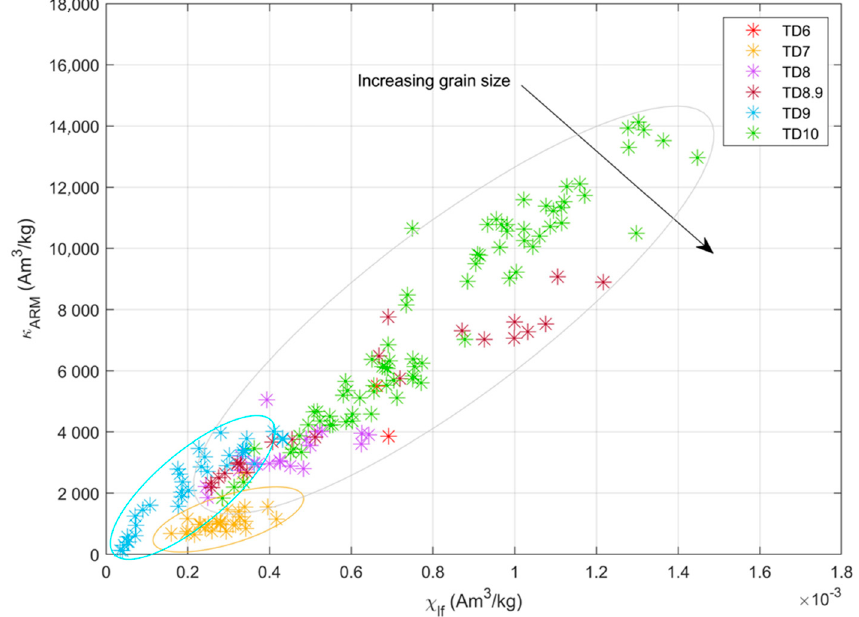
Figure 11. King plot of the di ff erent stratigraphic units. Three di ff erent groups of grain size can be distinguished: the smaller grain size, in light blue, is seen in some of the TD9 samples. The largest one, in yellow, is represented by TD7 samples, and, lastly, the most common grain size of all units is found in-between.